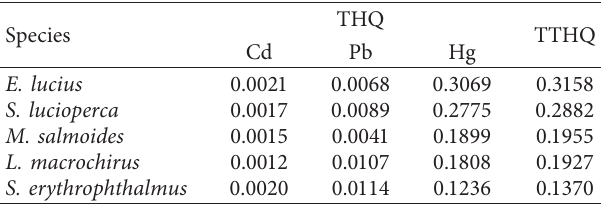
Figure 2: Seasonal variation in mean trace metal concentrations in muscles of the five fish species from the Mechraˆa-Hammadi Dam in Morocco (mg/kg of wet weight). Table 8: Target hazard quotient (THQ) and total THQ (TTQH) calculated for each species.